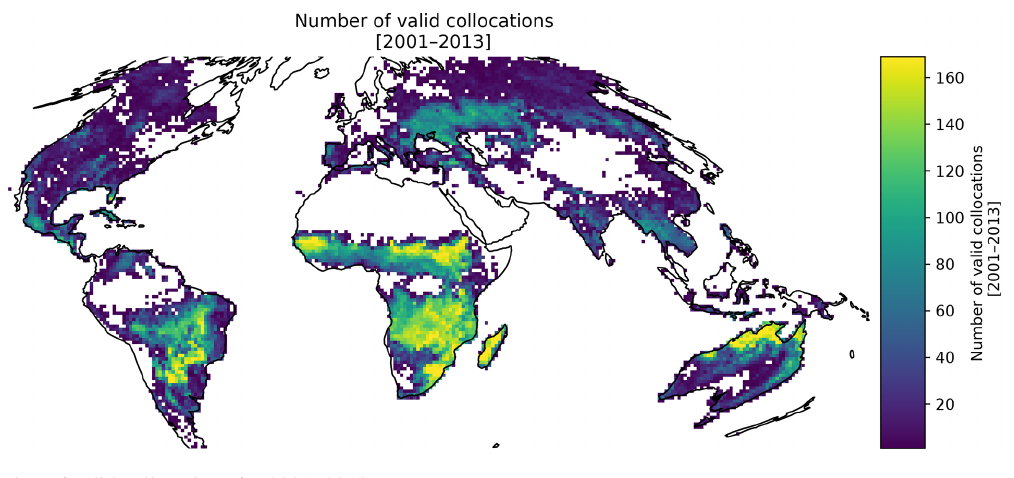
Figure 2. Number of valid collocations for 2001–2013.